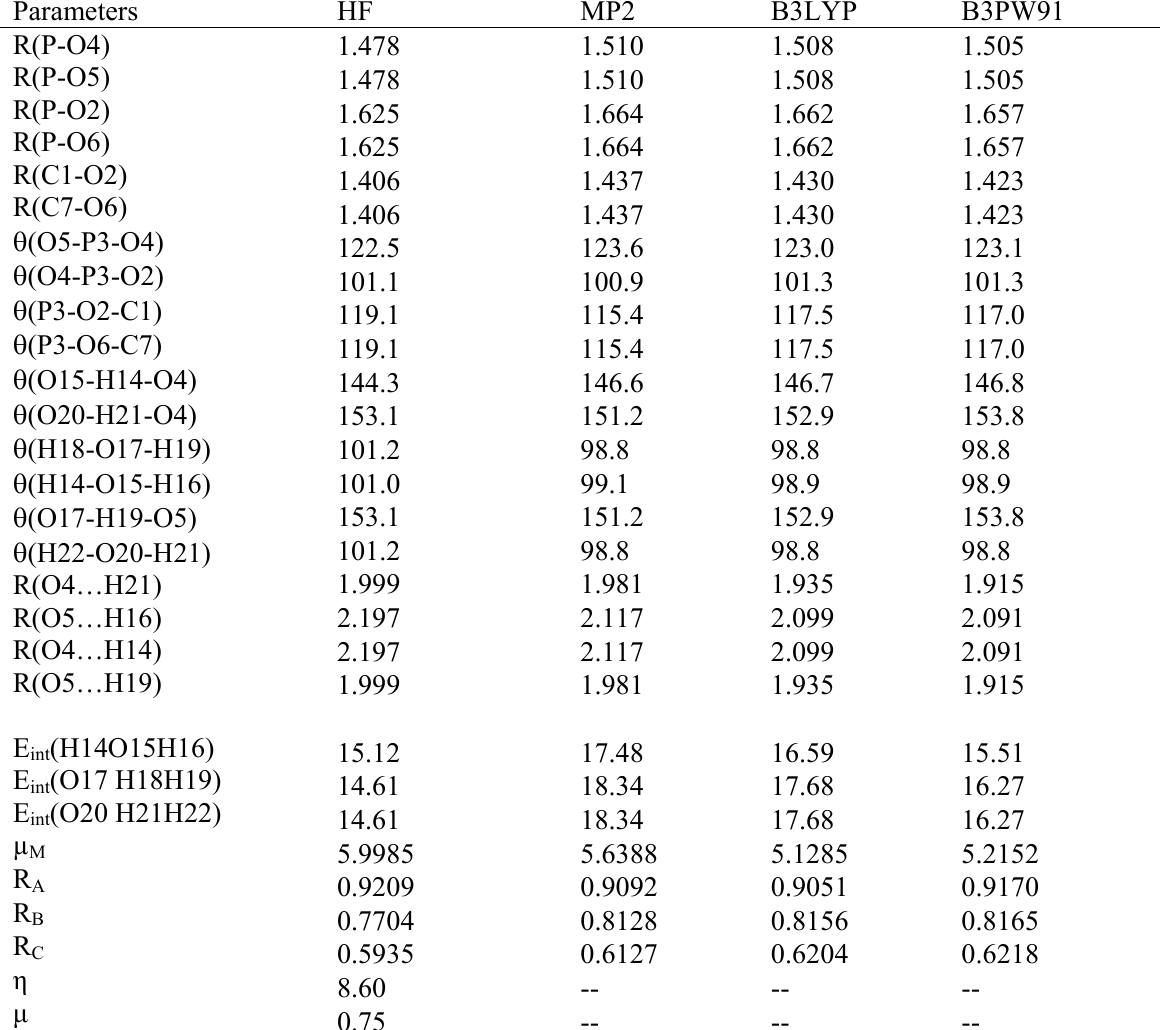
Table 4. Optimized geometrical parameters (bond length in Å, bond angle in degrees), rotational constants R , R , R (in GHz), dipole moment µ A B C chemical hardness η (in eV) for DMP-3 water